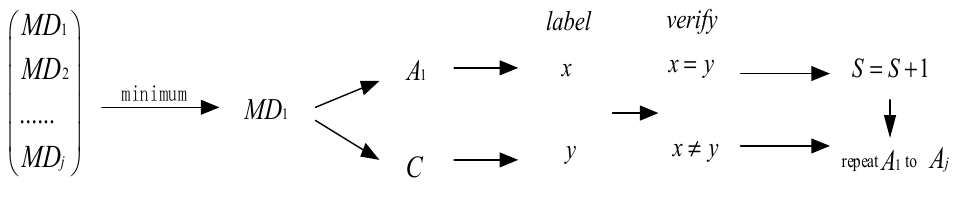
Figure 6. The forth step of aMMTS.